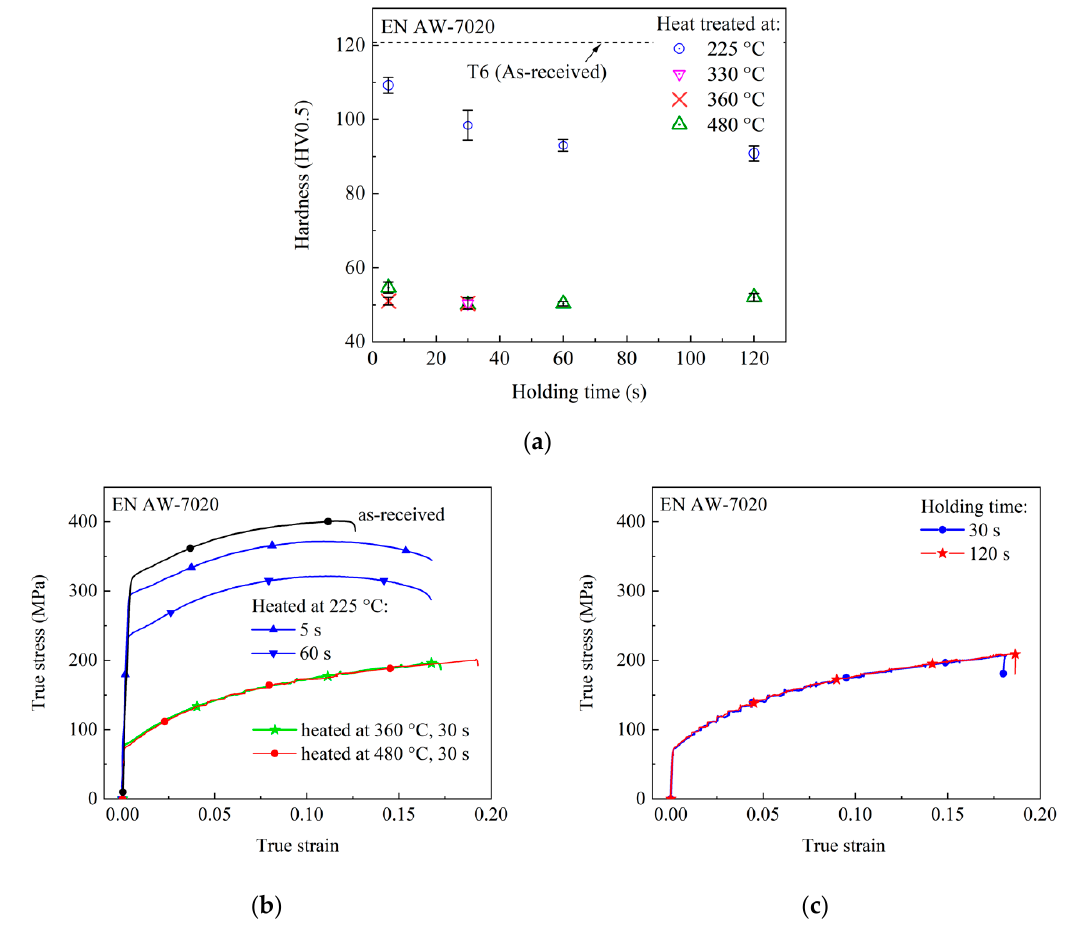
Figure 4. Change of mechanical properties of the alloy EN AW-7020 after various thermo-mechanical processes. ( a ) As-quenched hardness values after heat treatment processes at various holding times for different temperatures. ( b ) Room temperature stress-strain curves at a strain rate of 0.1 s − 1 after various heat treatment processes. ( c ) Room temperature stress-strain curves at a strain rate of 0.01 s − 1 after solution heat treatment (SHT) (480 °C) with two different holding times.